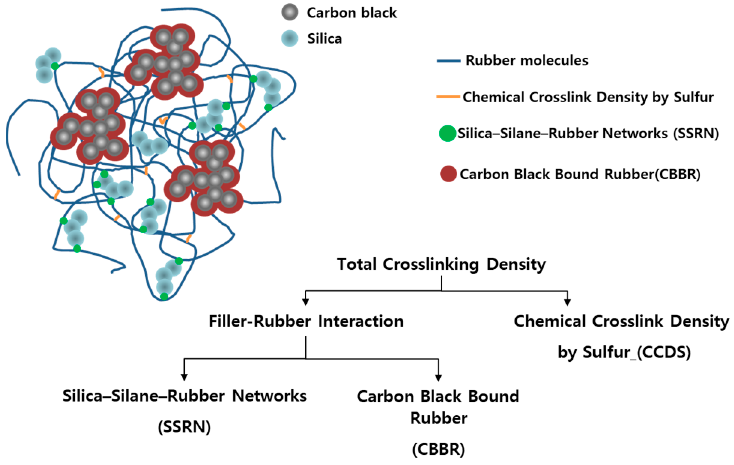
Figure 1. Vulcanizate structures with a carbon black and silica binary filler system.